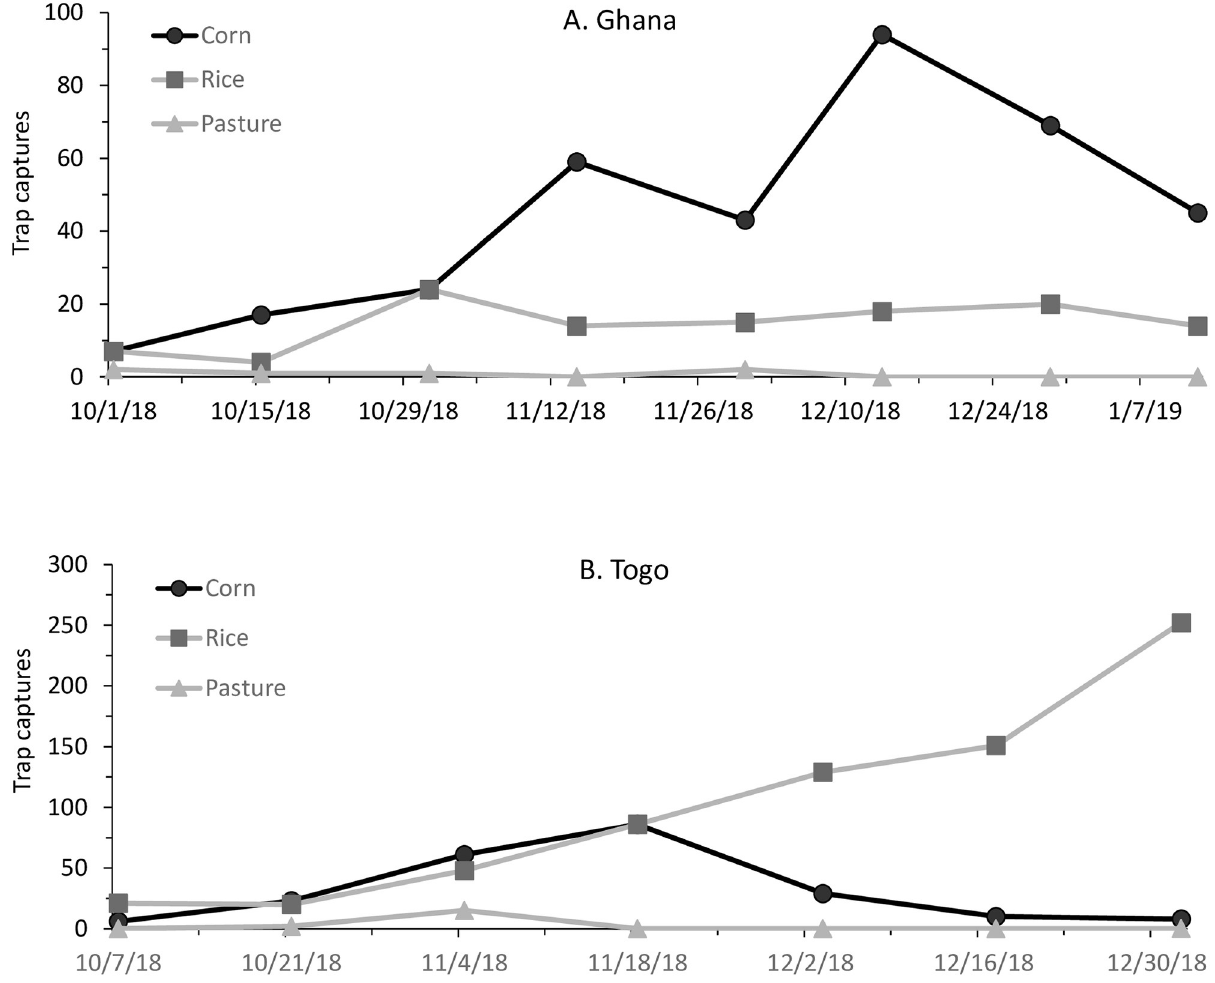
Fig 3. Graph of fall armyworm pheromone trap captures in corn, pasture, and rice habitats in Ghana (A) and Togo (B).